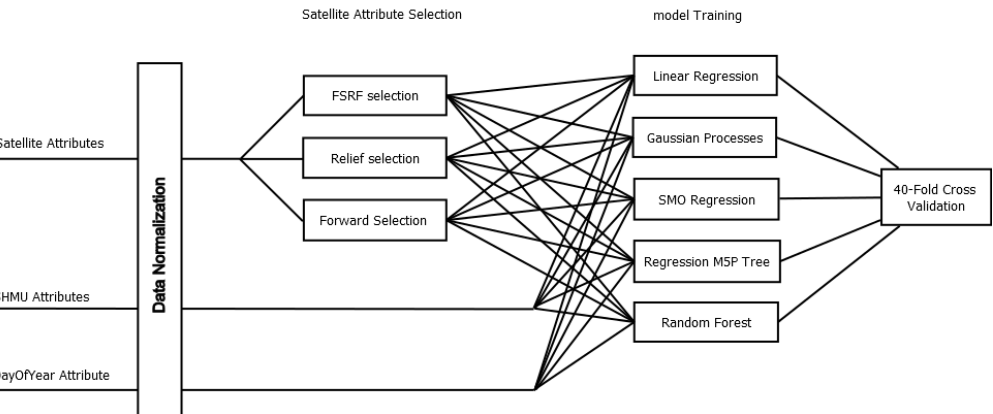
Figure 4. Flowchart view of our data preparation, modeling, and evaluation activities.